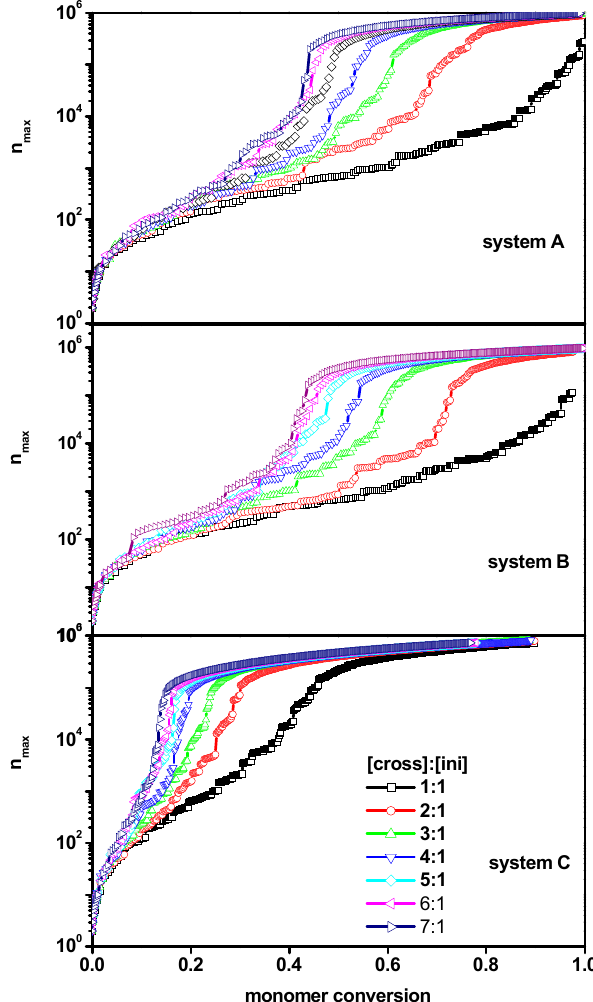
Figure 4. The evolution of maximum chain length with monomer conversion obtained for systems A, B and C. The initiator concentration is 0.6%, corresponding to the grafting density 0.6. The distance between the walls in the case of system B and C is d = 100. The values of the ratios [Ini]/[X] are given in the insets to the upper Figures.